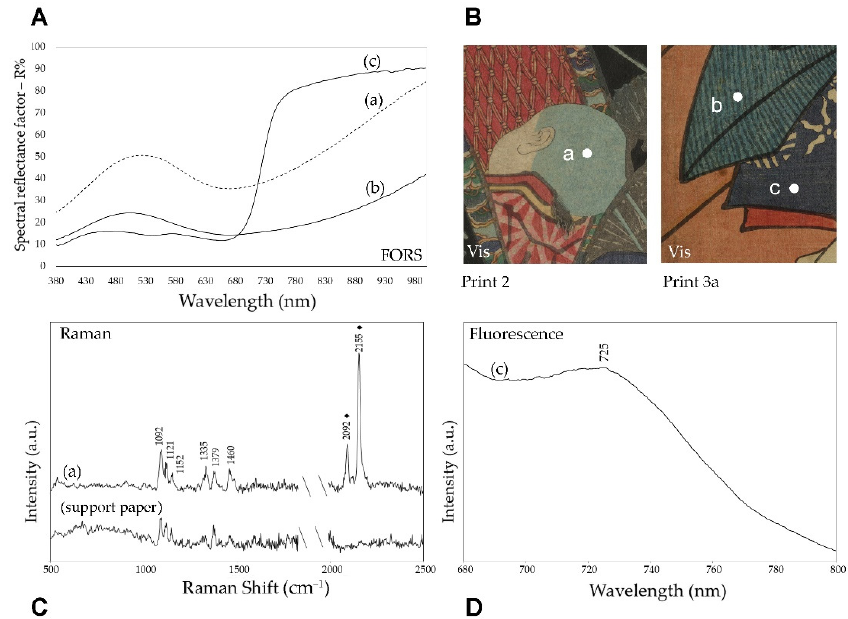
Figure 8. Blue details in print 2 and 3a: ( A ) FORS, ( C ) Raman SSE and ( D ) emission spectra ( λ exc = 562 nm) of three different areas (a), (b) and (c), as shown in the Vis detail ( B ). ( ♦ ) in the Raman SSE spectrum indicates the bands due to Prussian blue while the others are assigned to the support paper.